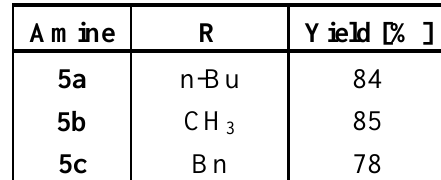
Table 1 . Yields of the amino components 5 prepared for the azomethine ylide